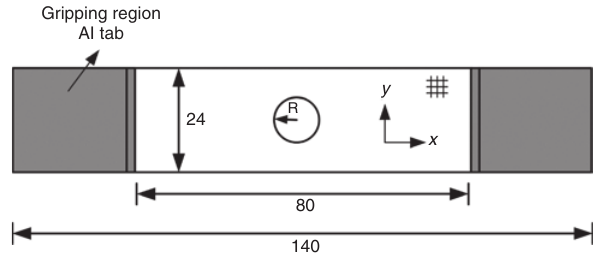
Figure 2: Specimen